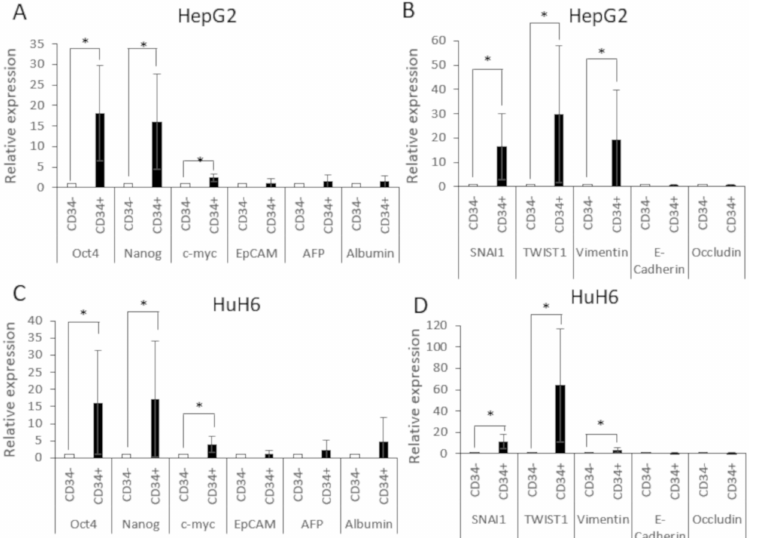
Figure 2. CD34 + CD90 + OV-6 + csVimentin + had increased expression of pluripotency and EMT factors. ( A , B ) Gene expression was analyzed in CD34 depleted (CD34 − ) and enriched (CD34 + ) fractions for Oct4, Nanog, c-myc, EpCAM, AFP, and albumin and for SNAI1, TWIST1, vimentin, E-cadherin and occludin in HepG2 cells and the same in HuH6 cells ( C , D ). The fold-change values of the CD34 − population were normalized to 1 and the values of CD34 + were calculated in relation to the respective values of CD34 − . The columns represent the means with error bars depicting the standard deviation from the mean. The experiment was repeated at least 7 times. A two-tailed Wilcoxon ranked test was performed in order to calculate the significance of the data (* p <